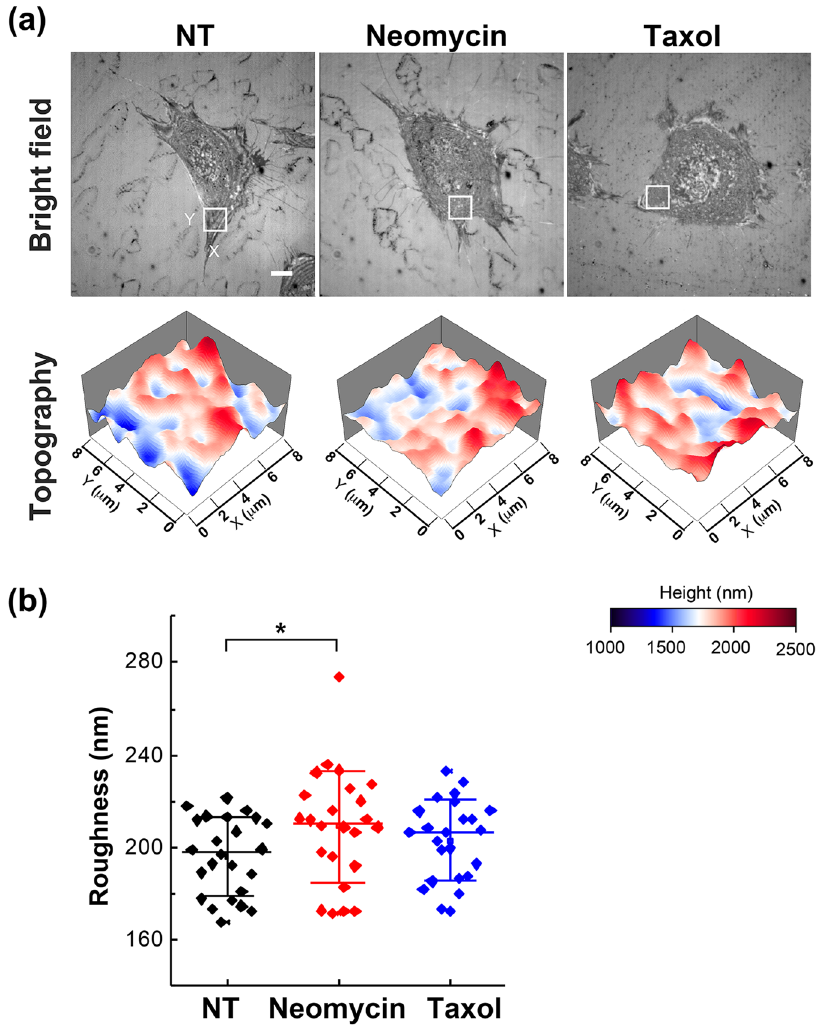
Figure 5. Membrane roughness of cells in response to cytoskeletal reagents. ( a ) Bright-field reflection image and the topography of MEFs measured by NIWOP. Cells were seeded on the 10 μ g/ml FN-coated polymer coverslip-bottom μ -dishes and treated with neomycin (3 mM) for 4 hours or Taxol (10 μ M) for 30 min followed by the NIWOP measurement. NT, no treatment. In each condition, the region marked by the white square in the bright-field image is displayed in the membrane topography. Scale bar, 10 μ m. ( b ) Membrane roughness of MEFs measured by NIWOP. Values represent mean ± standard deviation. * P < 0.05 (Student’s